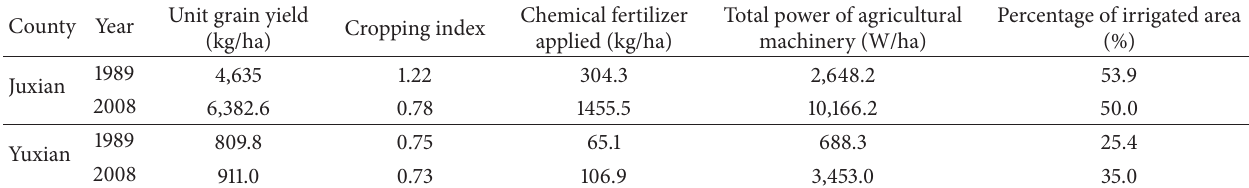
Table 6: Factors that affect grain